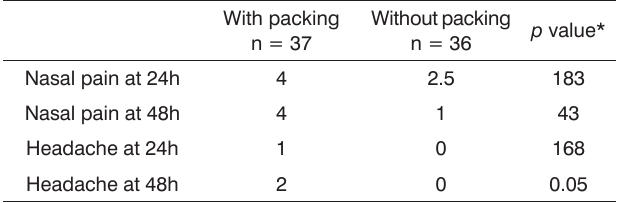
Table 1. Comparison of the VAS median of postoperative pain in patients with and without postoperative anterior nasal packing.